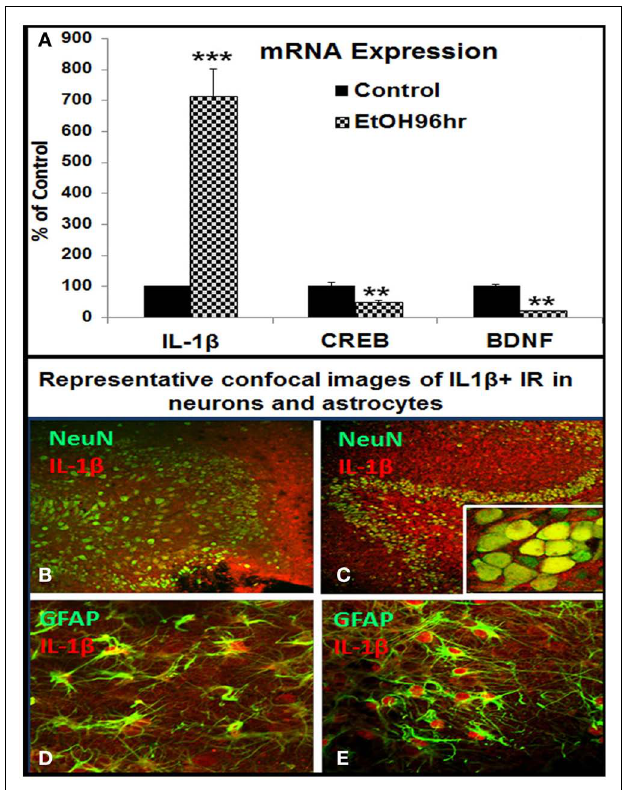
FIGURE 5 | Ethanol induction of proinflammatory cytokine IL-1 β in HEC slices. (A) Shown in bar graph are mRNA levels of IL-1 β , CREB, and BDNF from a representative experiment. Ethanol treatment (100mM, 4days) upregulated IL-1 β but downregulated CREB and BDNF mRNA expression. ANOVA following Fisher post hoc : *** p < 0.001 or ** p < 0.01 compared with control, n = 3. Cellular expression of IL-1 β IR was examined with double fluorescent immunostaining and confocal analysis. (B,C) Representative confocal photographs of double immunofluorescent staining with anti-IL-1 β (red) and neuronal marker NeuN (green) show ethanol induction of IL-1 β IR expression in neuronal cells of DG region [ (B) control; (C) ethanol, original magnification 20 × , insert in (B) 160 × ]; (D,E) representative confocal photographs of double immunofluorescent staining with anti-IL-1 β (red) and astrocyte marker GFAP (green) show ethanol induced strong expression of IL-1 β IR in astrocytes [ (D) control; (E) ethanol, original magnification 40 ×